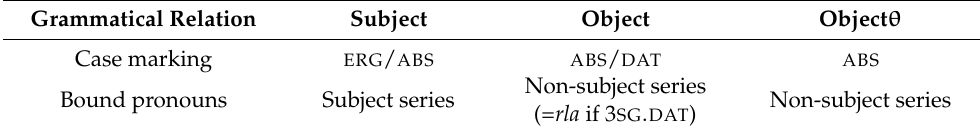
Table 2. Identifying core grammatical relations in